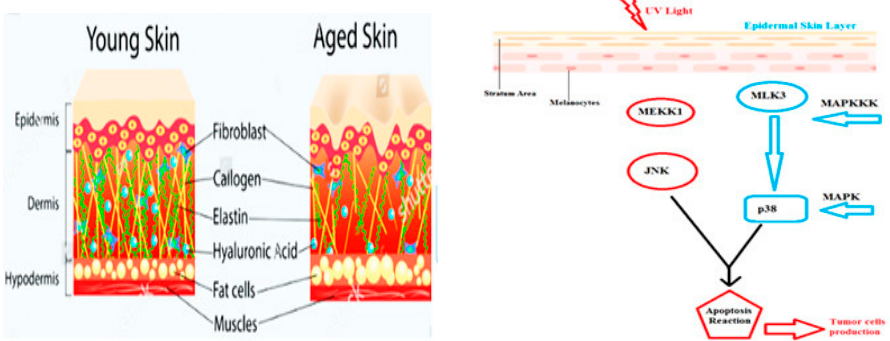
Figure 2. Showing the UV light effect in changing the structure of fibroblast cells which convert normal cell lines into tumor cells via MAPK and JNK pathways [54,55].